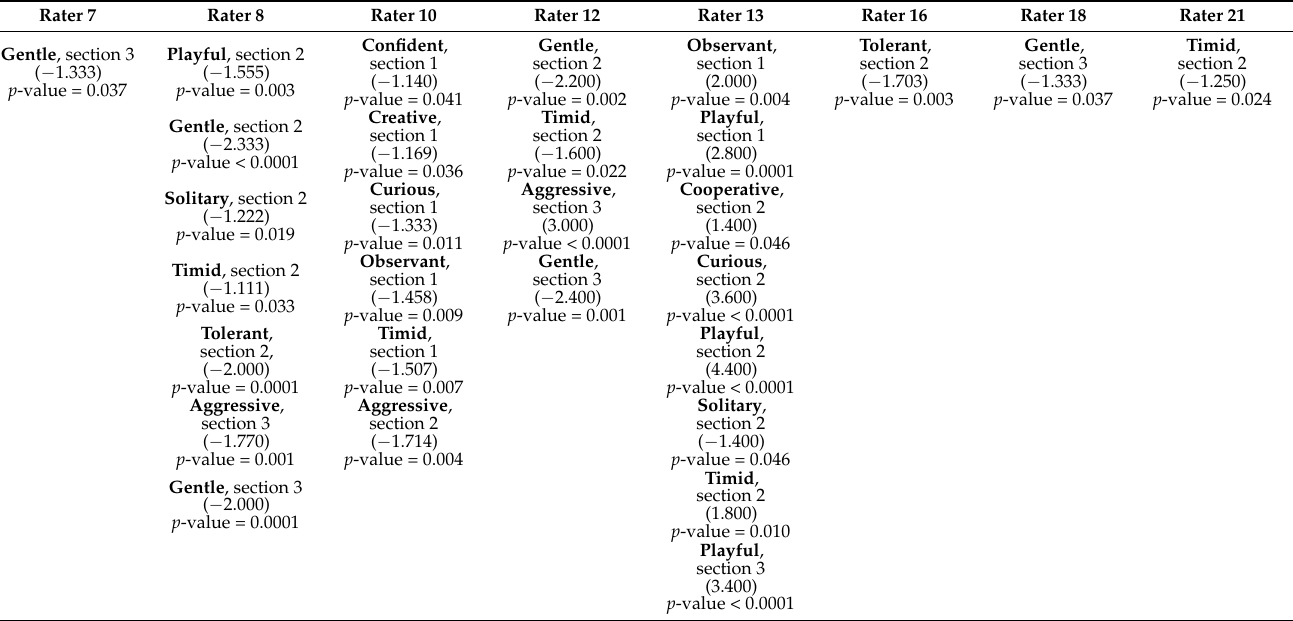
Table 3. Statistically significant (5% of significance level) mean differences of scores in tests 1 and 2 for raters by section and adjective (in bold). Note that each rater always scored the same sample of